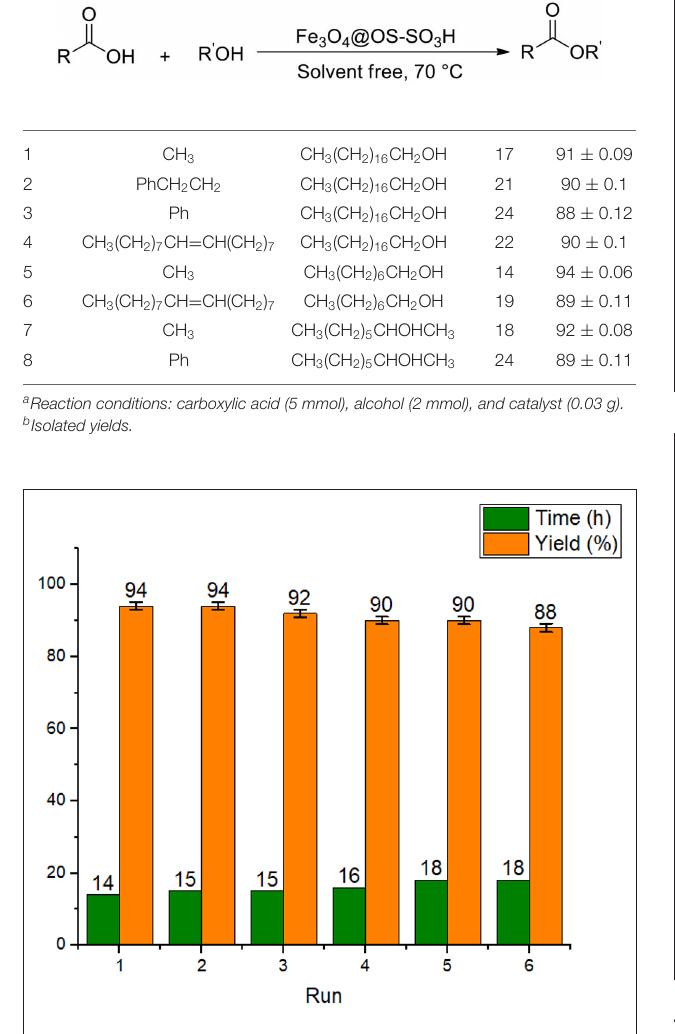
FIGURE 9 | Reusability of the Fe 3 O 4 @OS-SO 3 H nanocatalyst.